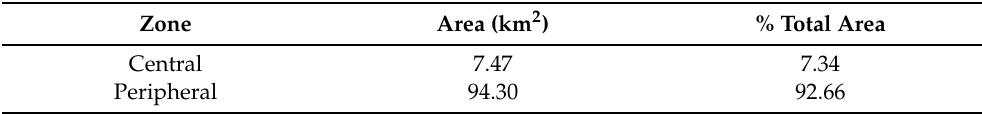
Table 2. Two-zones division resulting